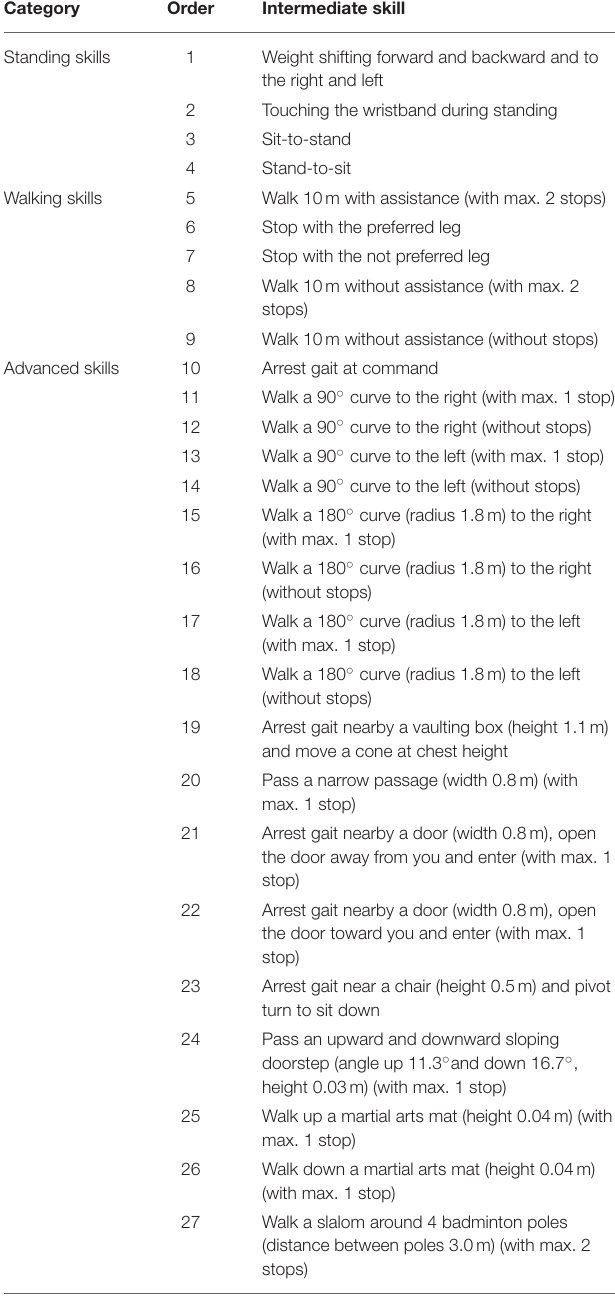
TABLE 1 | Assessed exoskeleton skills in the